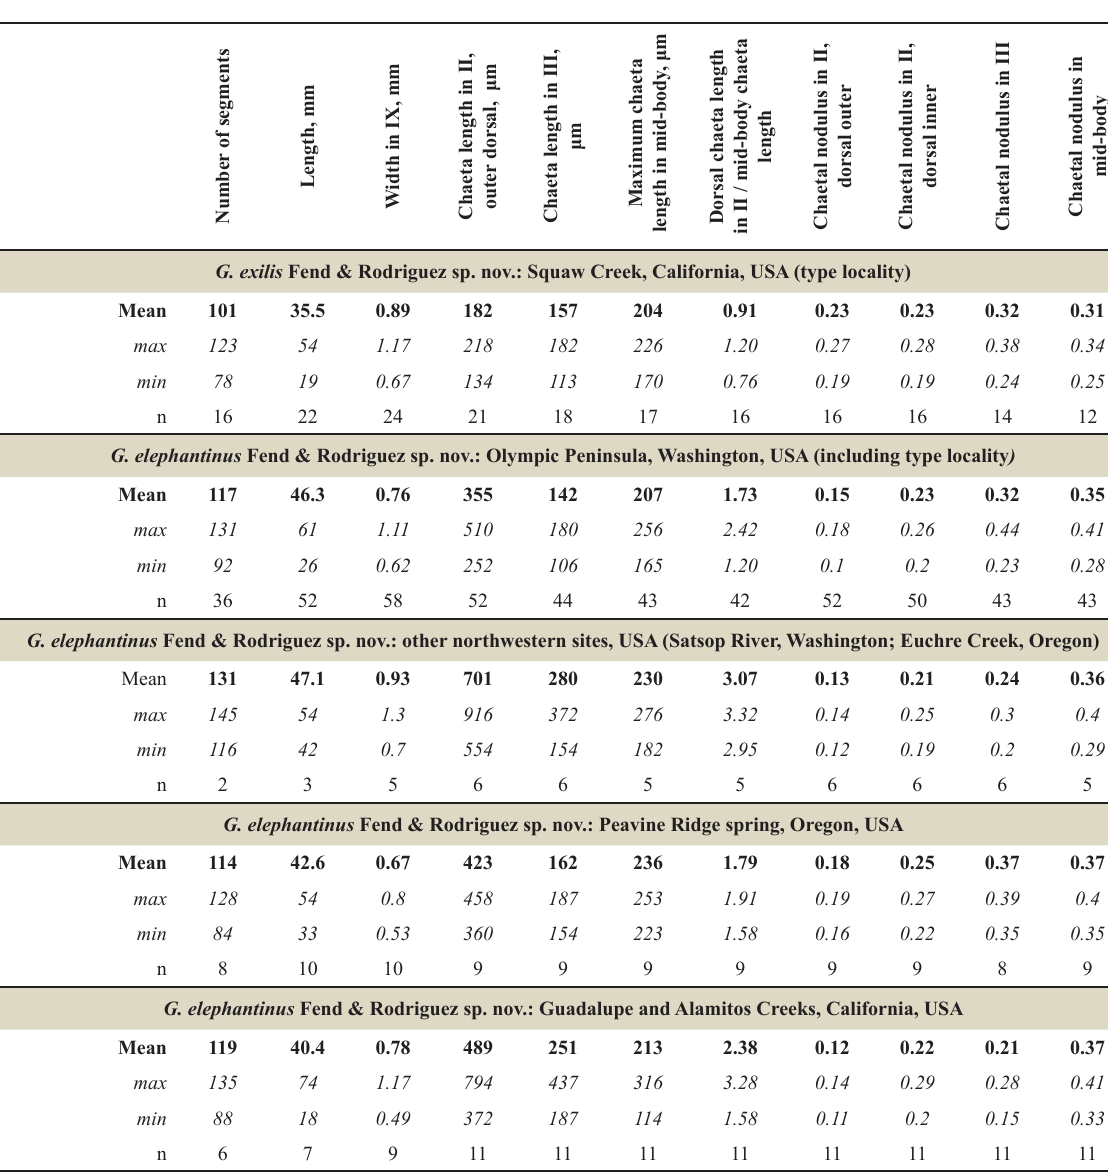
Table 3. Descriptive measurements (mean, range, and n) for different populations of G. exilis Fend & Rodriguez sp. nov. and G. elephantinus Fend & Rodriguez sp. nov. Measurements of “nodulus” refer to the proportional distance from the tip of the chaeta (i.e., “0.5” means the nodulus is at the midpoint of the